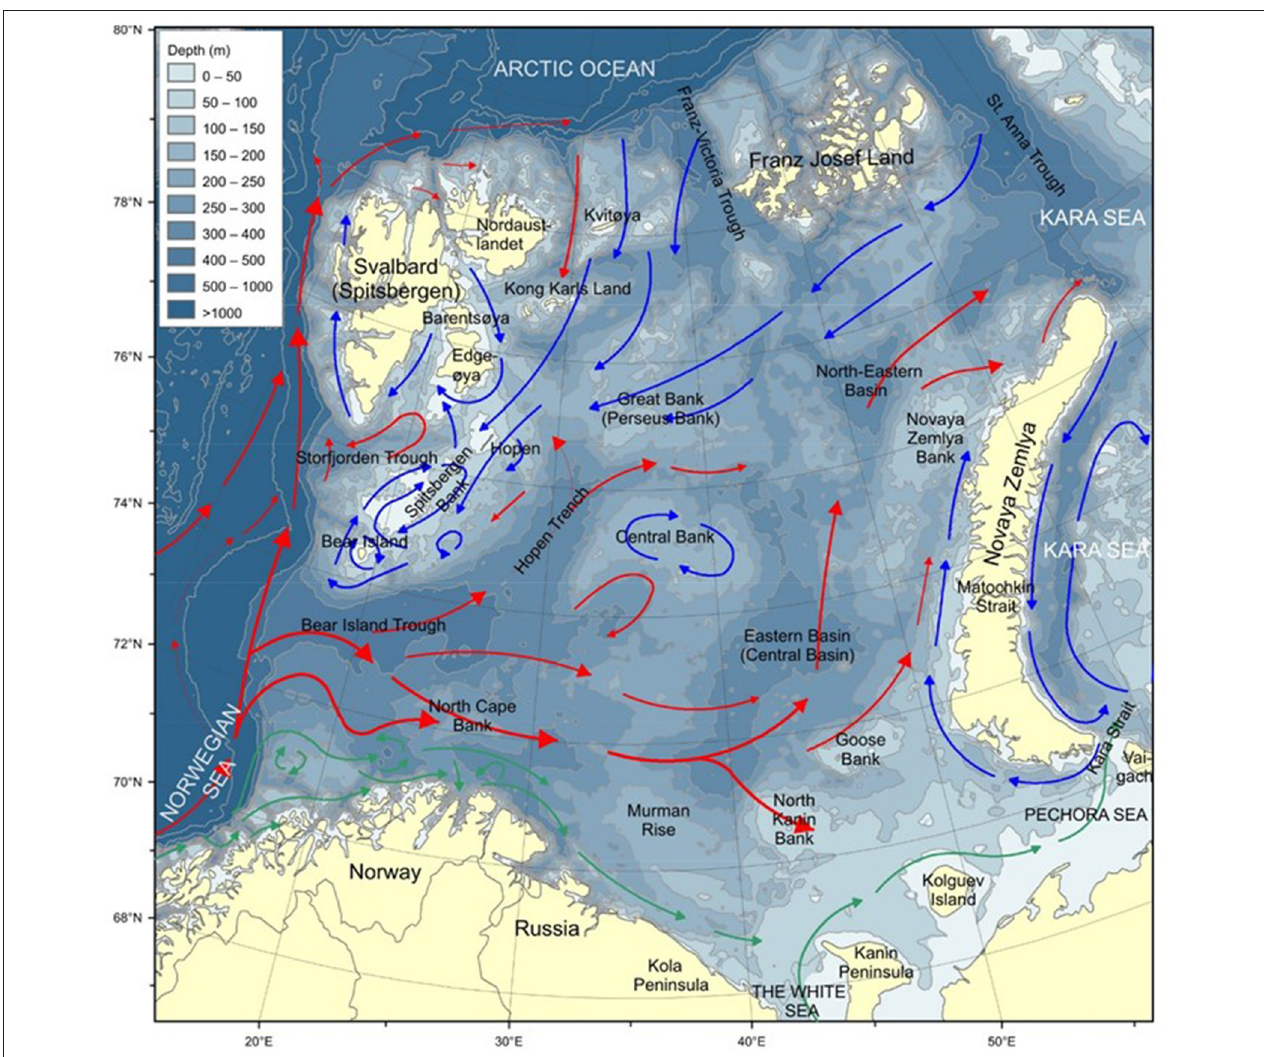
FIGURE 1 | The Barents Sea. Red arrows show Atlantic water currents, blue arrows Arctic currents and green arrows currents of coastal waters. Published with courtesy of Institute of Marine Research, Norway.